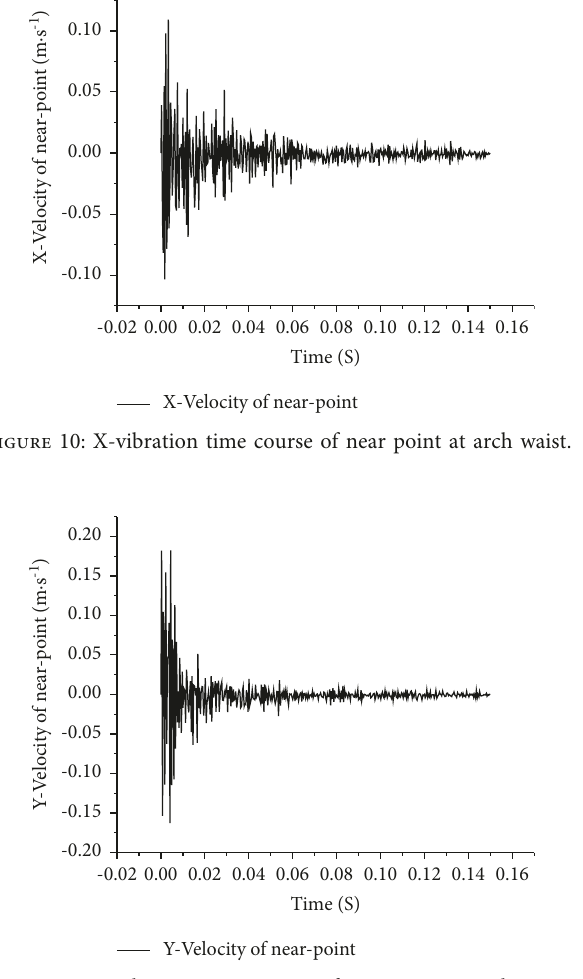
Figure 13: Y-vibration time course of far-point at arch